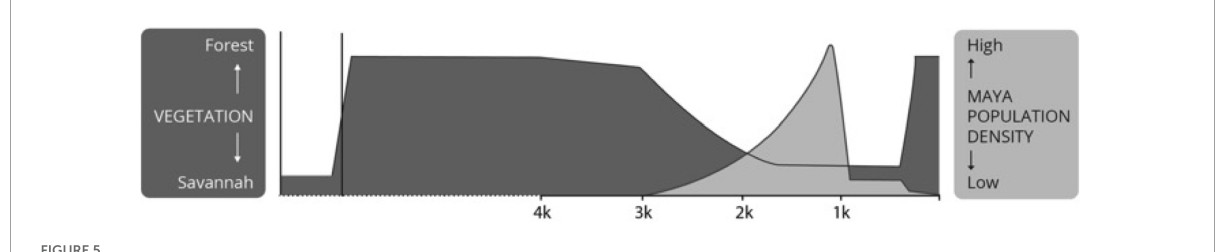
FIGURE5 Interpretation of pollen in the Maya forest redrawn based on original presentations of Binford et al. (1987), Rice (1996), and Webster (2002) showing the impression of dramatic deforestation. Credit ISBER/MesoAmerican Research Center,